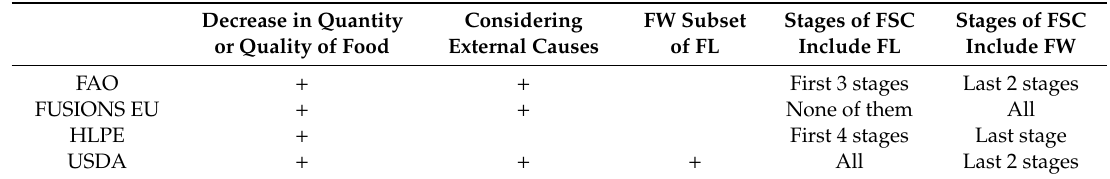
Table 2. Summary of similarities and di ff erences of definitions.